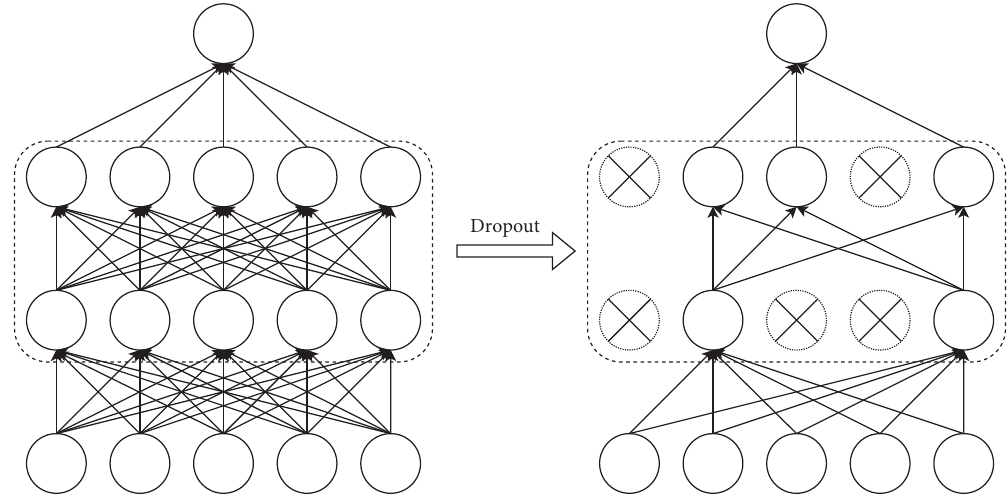
Figure 2: Schematic diagram of the dropout